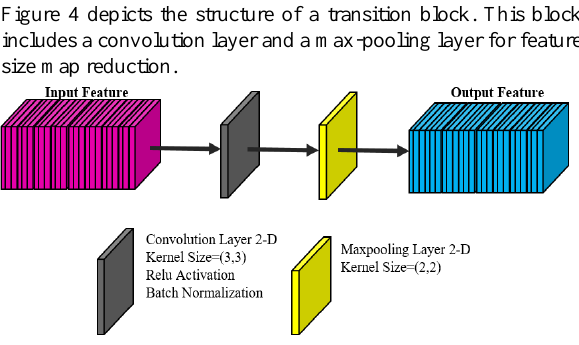
Figure 4 . The structure of transition